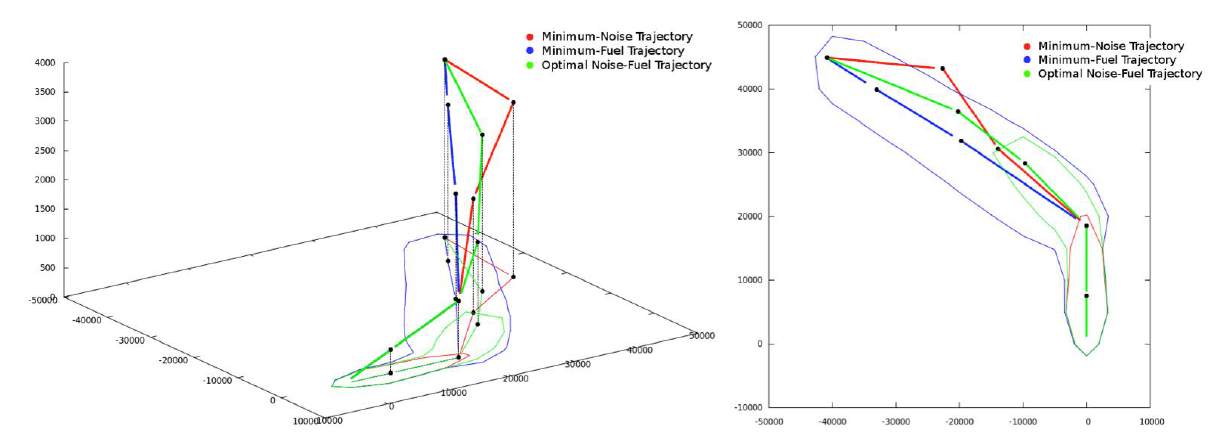
Figure 5: Optimized approach and landing procedures to minimize noise and fuel burned. Influence of the α and β